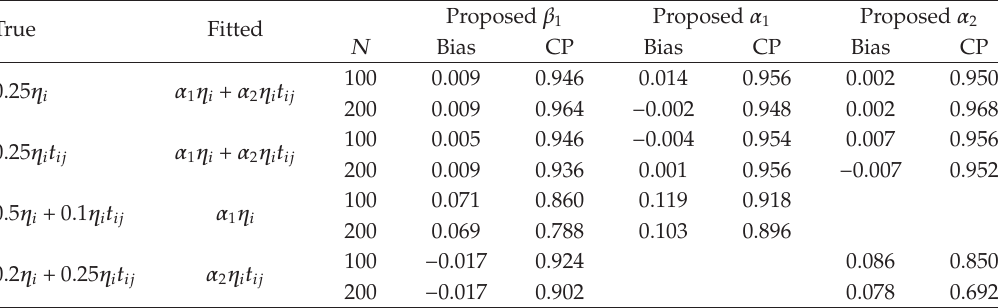
Table 3: Sensitivity analysis for misspecified models under mixed types of